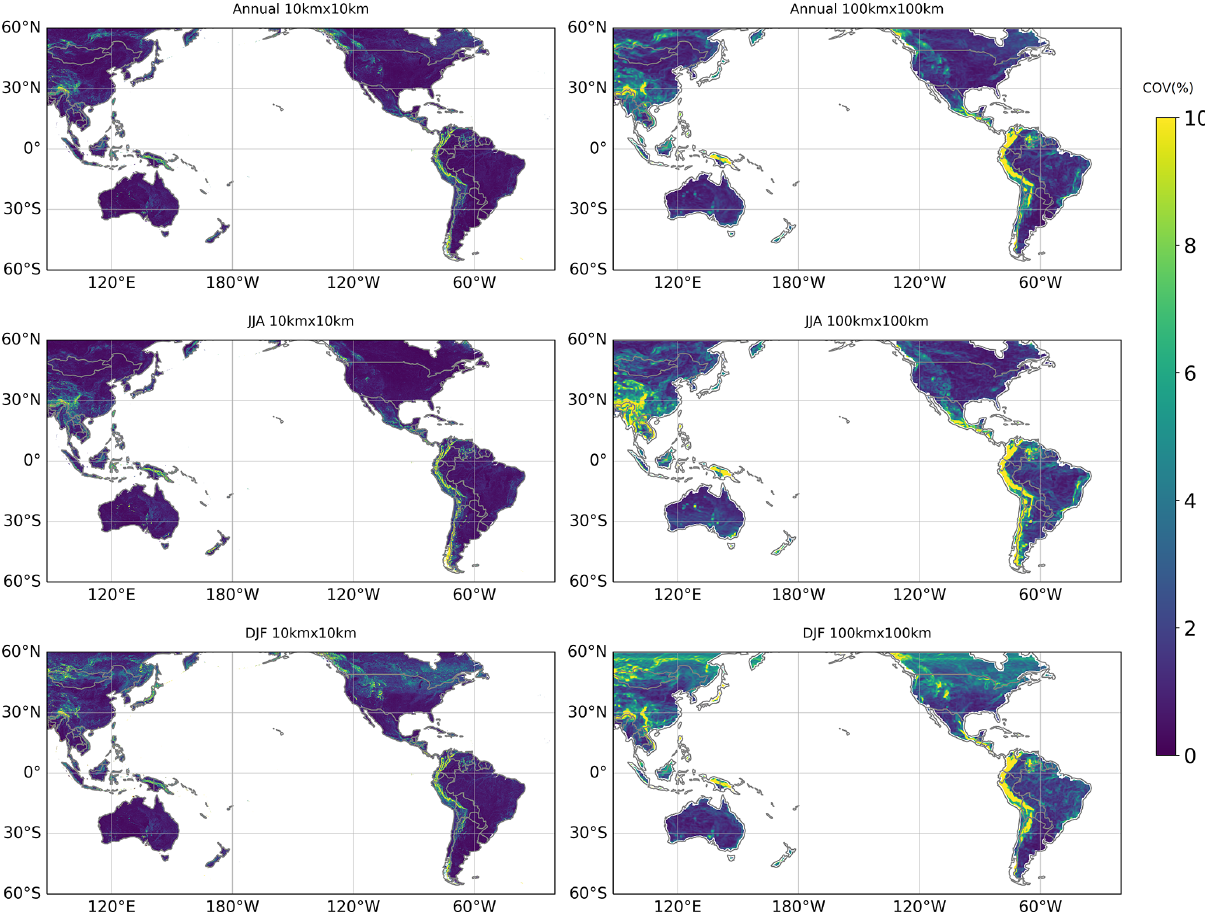
Figure 15. The annual, JJA (June, July, and August), and DJF (December, January, and February) aggregated spatial coefficient of variance (COV) maps at 10km × 10km and 100km × 100km